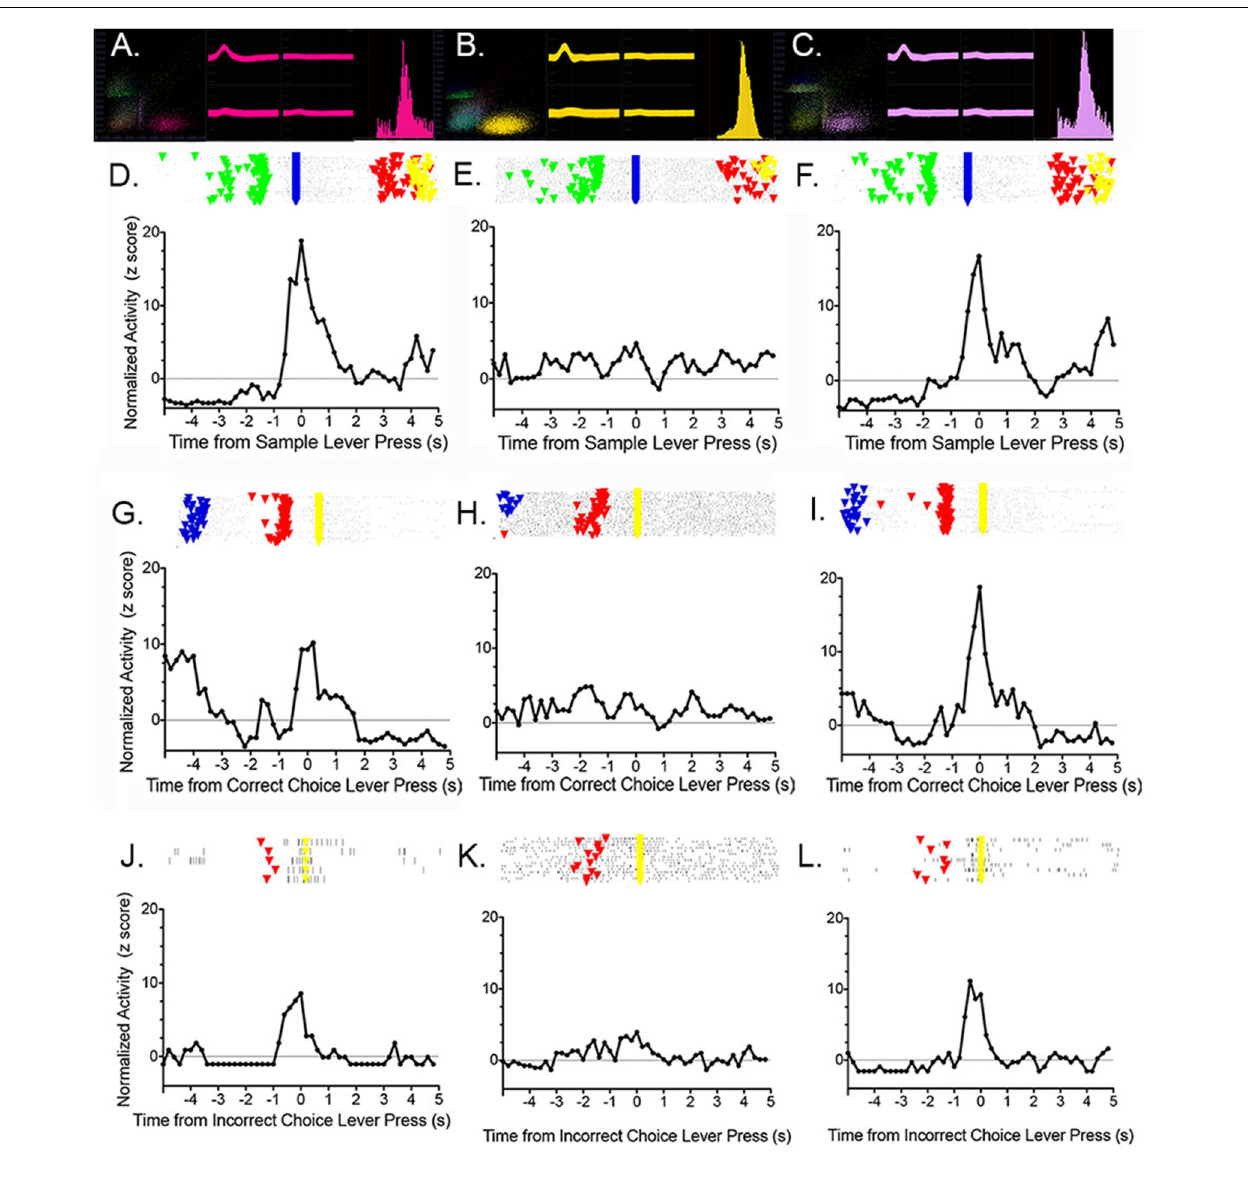
FIGURE 13 | Effects of unilateral thalamic inactivation by 1.0 nmol muscimol near the junction of the paracentral and mediodorsal nuclei on a reinforcement anticipation (RA) response in ipsilateral mPFC. Results are shown for pre-inactivation day 1 (A,D,G,J) , inactivation day 2 (B,E,H,K) , and post-inactivation day 3 (C,F,I,L) . 3D cluster plots, waveforms at each tetrode wire, and the interspike interval histograms (A,B,C) confirm the identity of the neuron held across 3 days and show the increase in activity observed during thalamic inactivation. Rasters and normalized PETHs aligned with sample (D,E,F) , correct choice (G,H,I) , and incorrect choice (J,K,L) reveal typical RA responses on days 1 and 3 that disappear during day 2 thalamic inactivation. Figure reproduced from Francoeur et al. (2019).